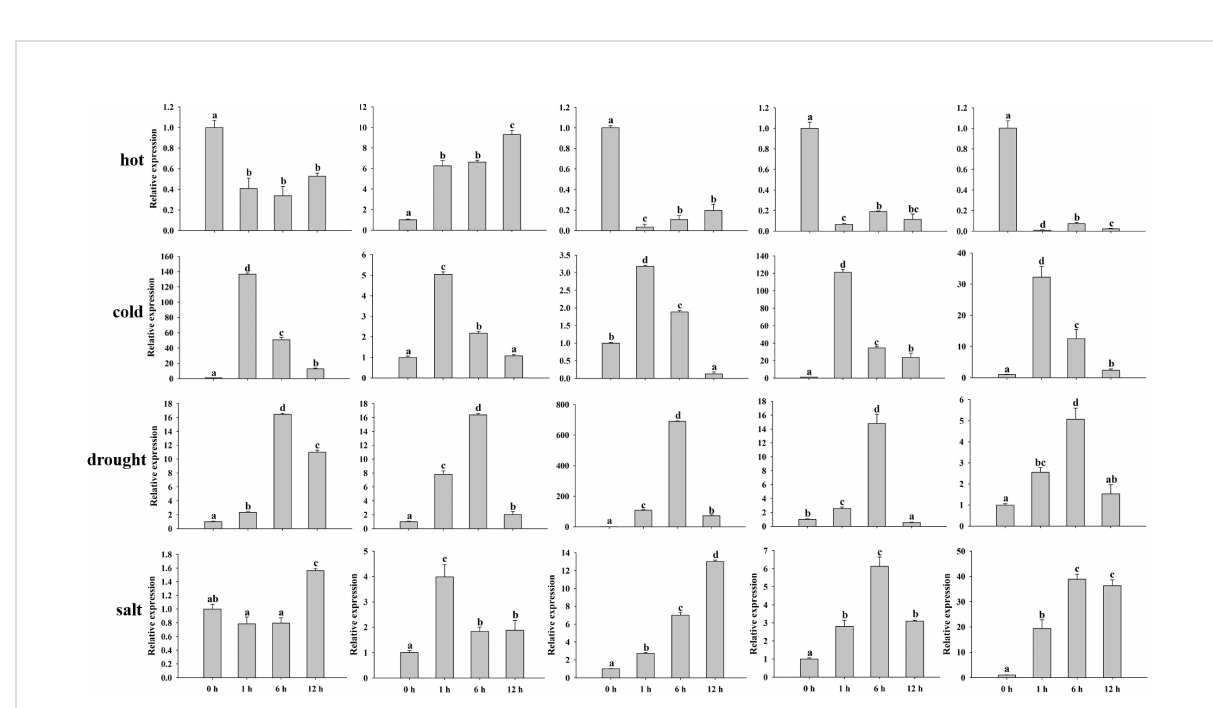
FIGURE 9 Analysis of the relative expression levels of peanut AhMADS genes by qRT-PCR. The expression pro fi les of fi ve peanut AhMADS genes (AhMADS9, AhMADS21, AhMADS34, AhMADS50, and AhMADS64) under four stresses (cold, hot, drought, and salt) were validated. The data are presented as the mean ± SD (n = 3), and the values differed signi fi cantly at p < 0.05. Different letters indicate signi fi cant differences.